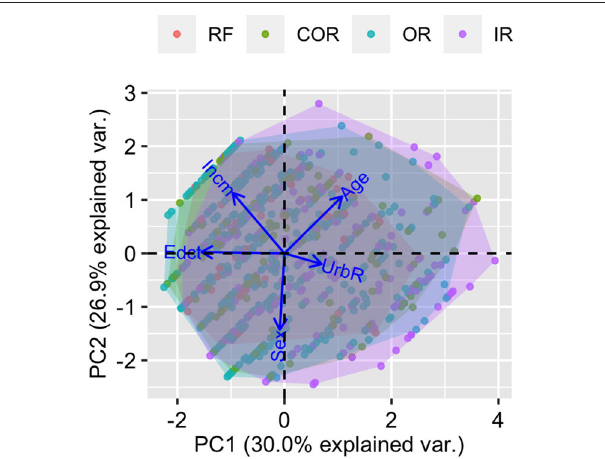
FIGURE 3 | Bi-plot of the first two components of the Principal Component Analysis (PCA) of demographic characteristics of the four OR and IR activities considered here. Each dot represents a sample (survey) and the colors represent the different profiles. The vectors show the demographic variables: Sex, urban vs. rural (UrbR), age, economic input (Incm), and education level